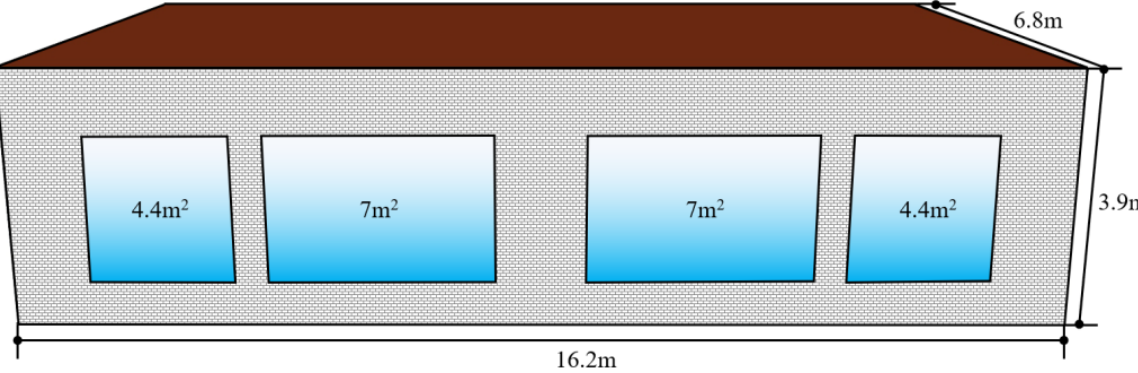
Figure 4. Building load model.